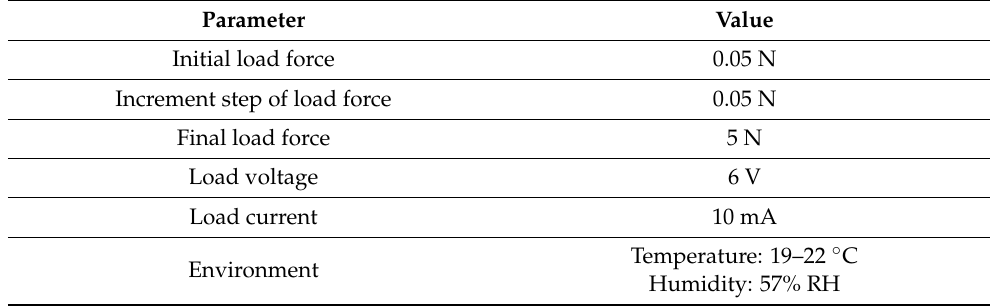
Table 1. Experimental conditions.